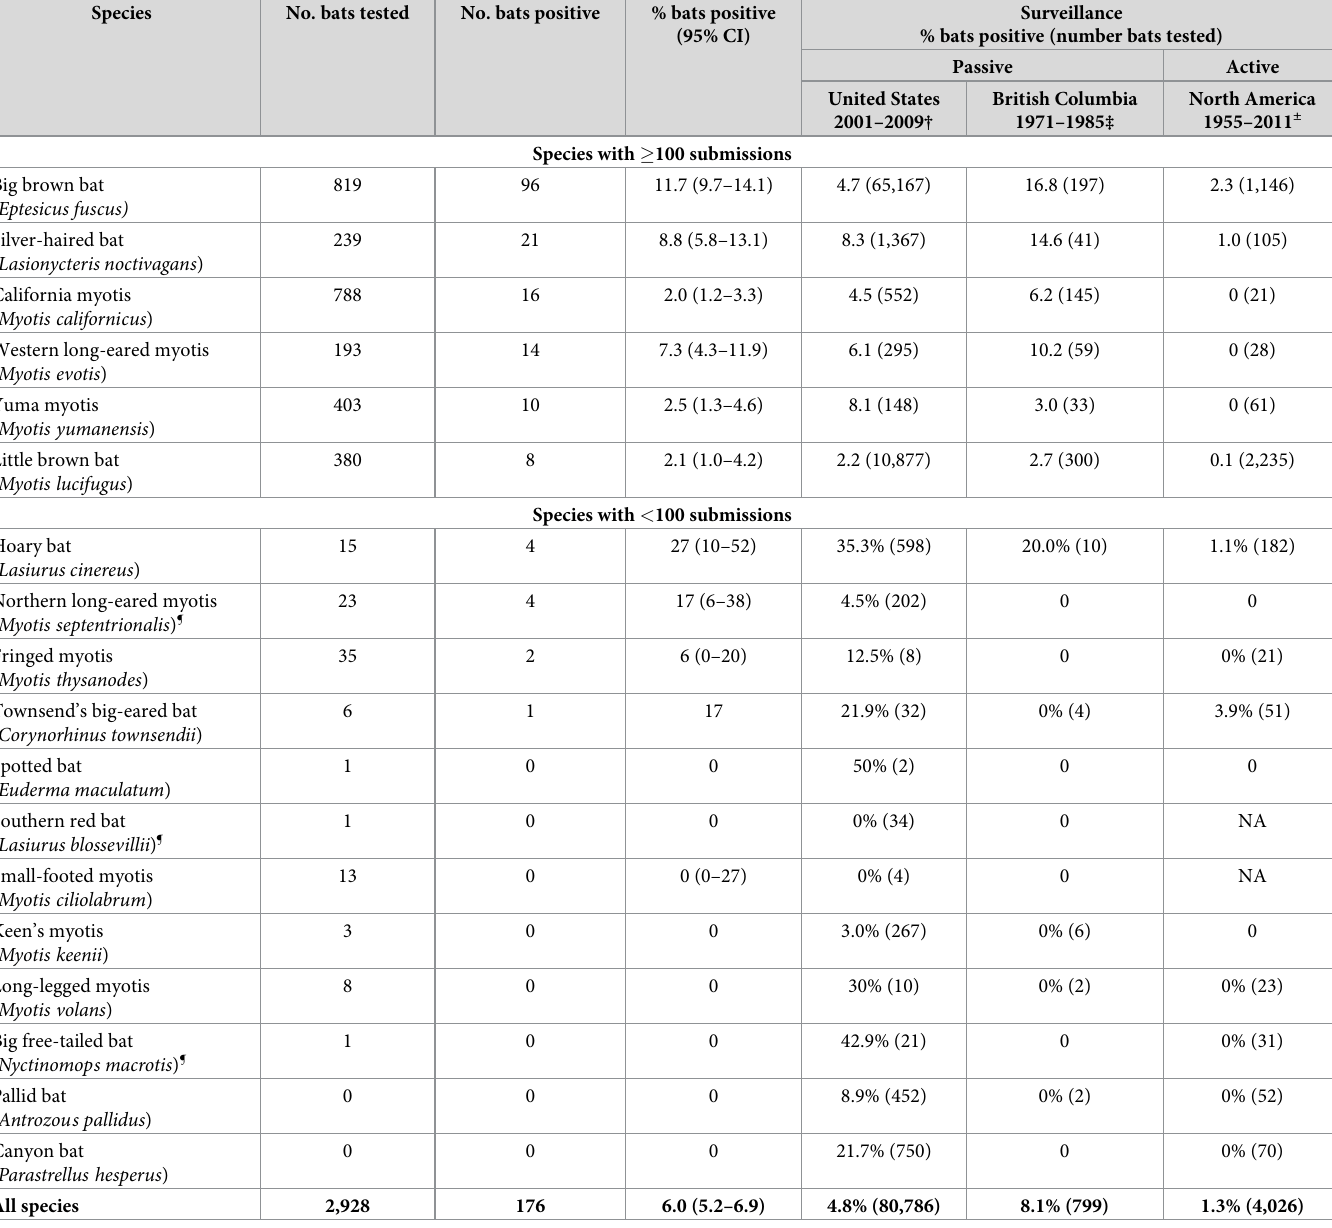
Table 2. Number of identified bats with definitive RABV test result (N = 2,928), number of rabid bats, and bat RABV positivity by species identified by morpholog- ical keys, Washington State—2006–2017.